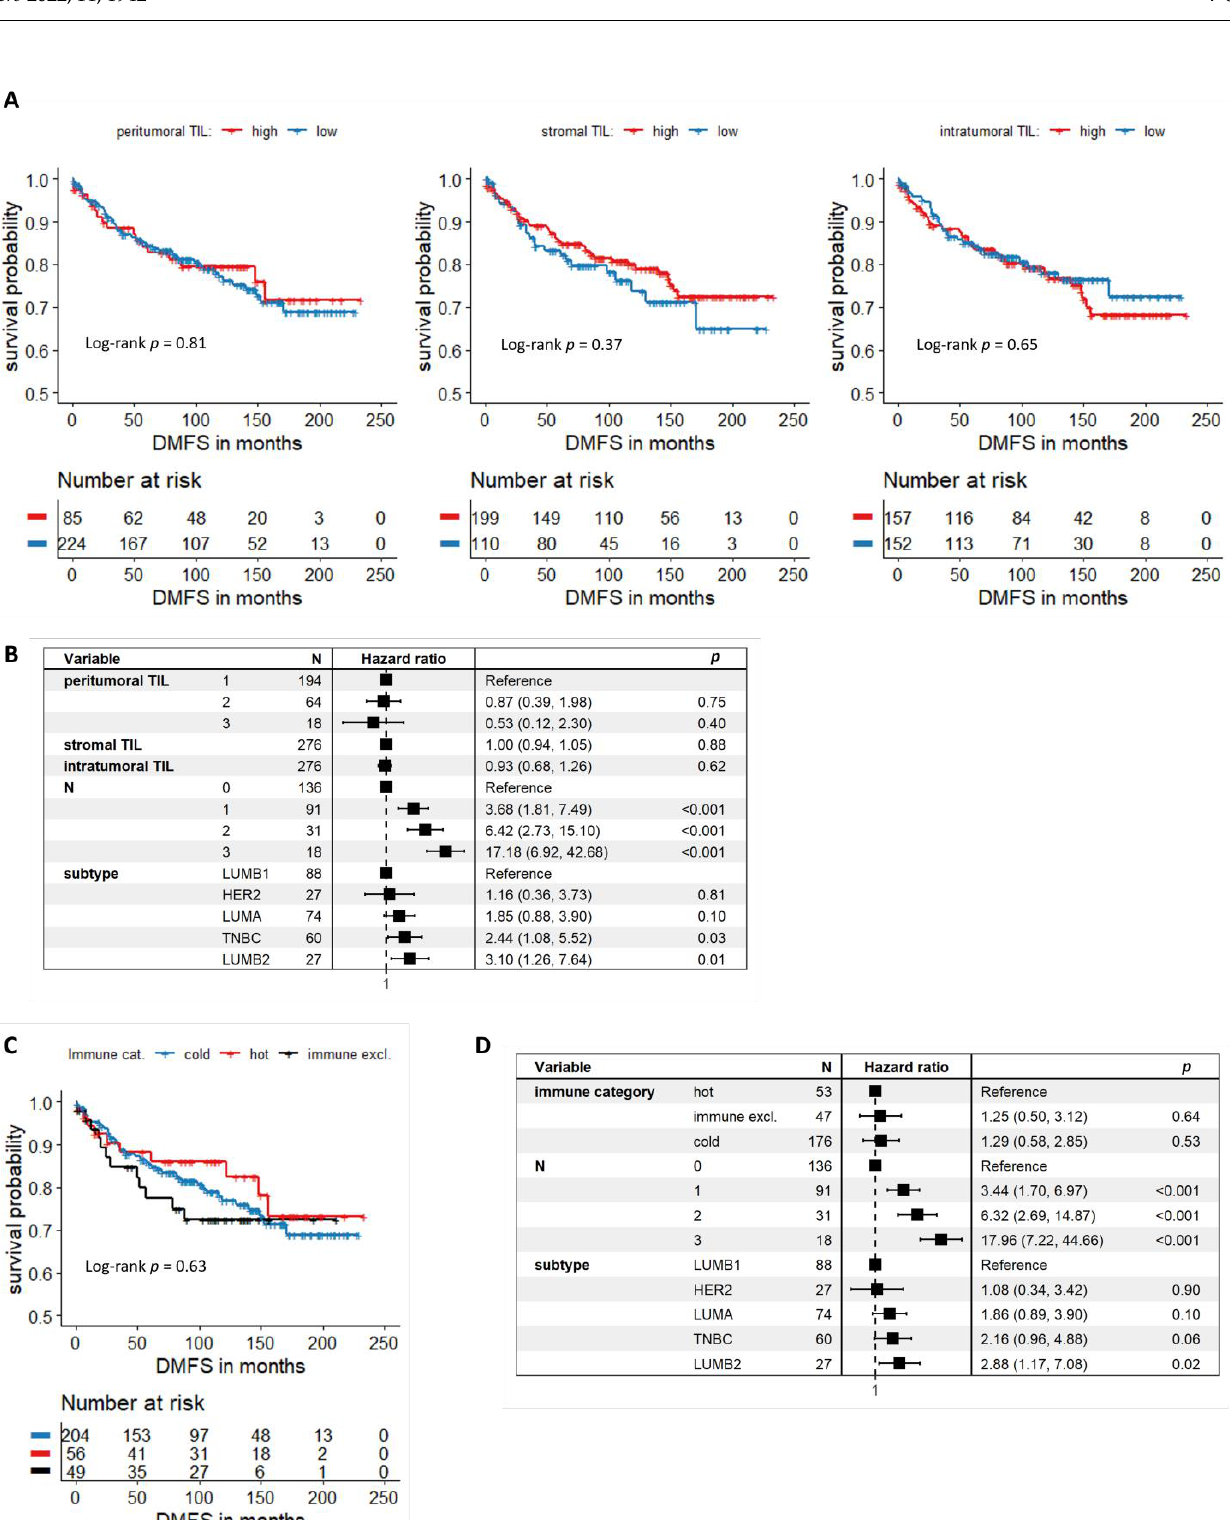
Figure 2. Associations between DMFS and TIL levels at different localizations: A, Kaplan–Meier curves of patients with high and low pTIL, sTIL and iTIL ( n = 309). B, Forest plot depicting multivariate Cox regression results where TILs at different localizations were treated as independent variables. Patients ( n = 276) were stratified based on tumor grade. C, Kaplan–Meier curves of patients with cold, hot and immune-excluded tumors ( n = 309). D, Forest plot depicting multivariate Cox regression results where one independent variable is the tumors’ immune category. Patients ( n = 276) were stratified based on tumor grade.